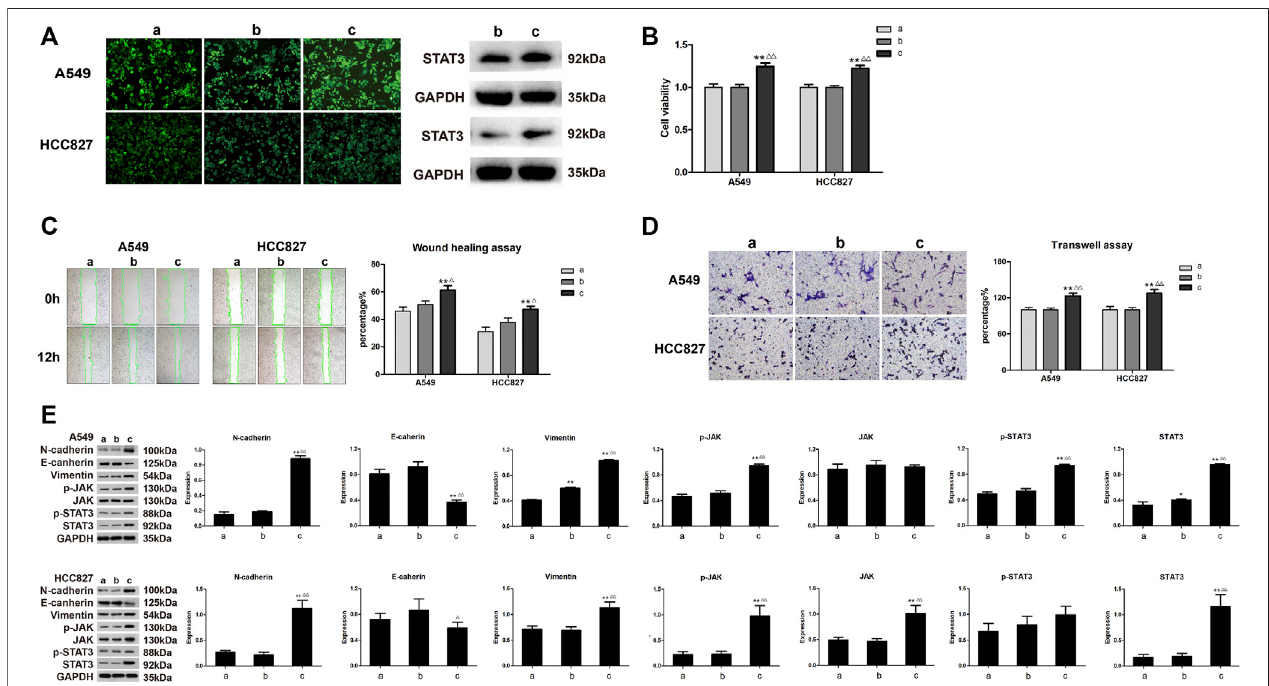
FIGURE 8 | The effects of STAT3-OE for A549 and HCC827 cells on LC cells were opposite to those being performed with AETW. (A) Expressions of stable transducedcelllines. (B) QuantitativeanalysesofA549andHCC827cellviabilitiesbytheCCK-8assay. (C) DetectionsofmigrationofLCcellstreatedwithSTAT3-OEby the wound healing assay and their quantitative analyses. (D) Detections of invasion of LC cells treated with STAT3-OE using transwell plates and their quantitative analyses. (E) Expressions of cadherins, vimentin, and JAK/STAT3 axis signaling proteins by western blot analyses and their quantitative analyses. Compared with thecontrolgroup,* p < 0.05,** p < 0.01.ComparedwiththeSTAT3-NC +AETW group, △ p < 0.05, △△ p < 0.01. a:controlgroup; b:STAT3-NC +AETW;c:STAT3-OE + AETW.